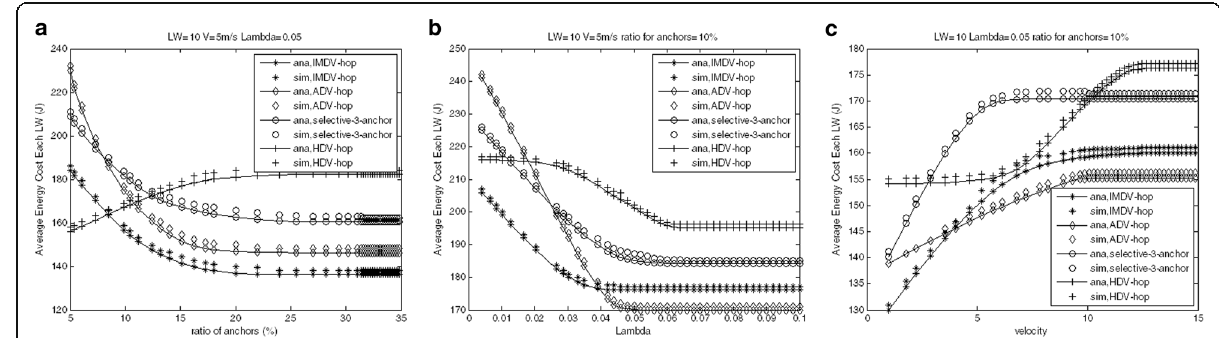
Fig. 12 Localization consumption comparisons. a Localization consumption comparisons for different schemes based on the ratio of anchors. b Localization consumption comparisons for different schemes based on node density. c Localization consumption comparisons for different schemes based on mobility velocity